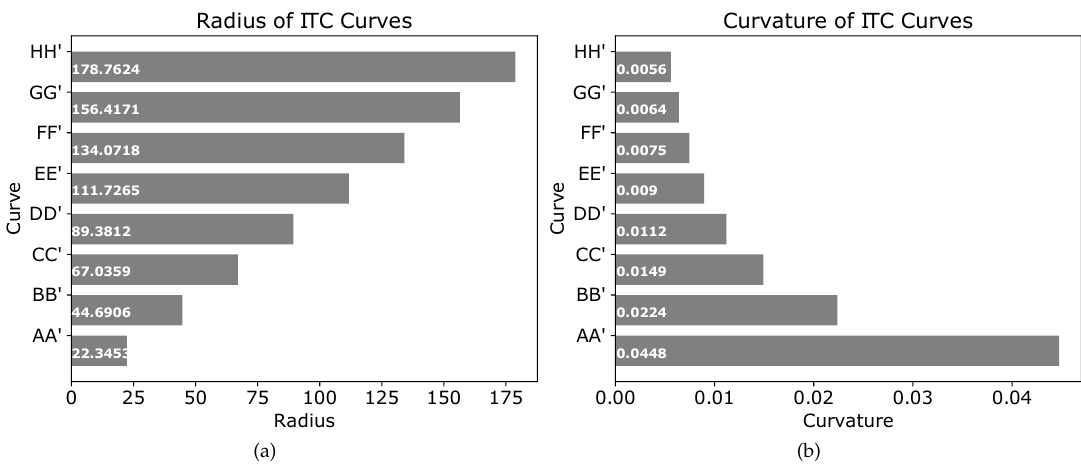
Figure 14. Radius and curvature of the different curves in Figure 13. ( a ) radius of curves at different points; ( b ) curvature of curves at different